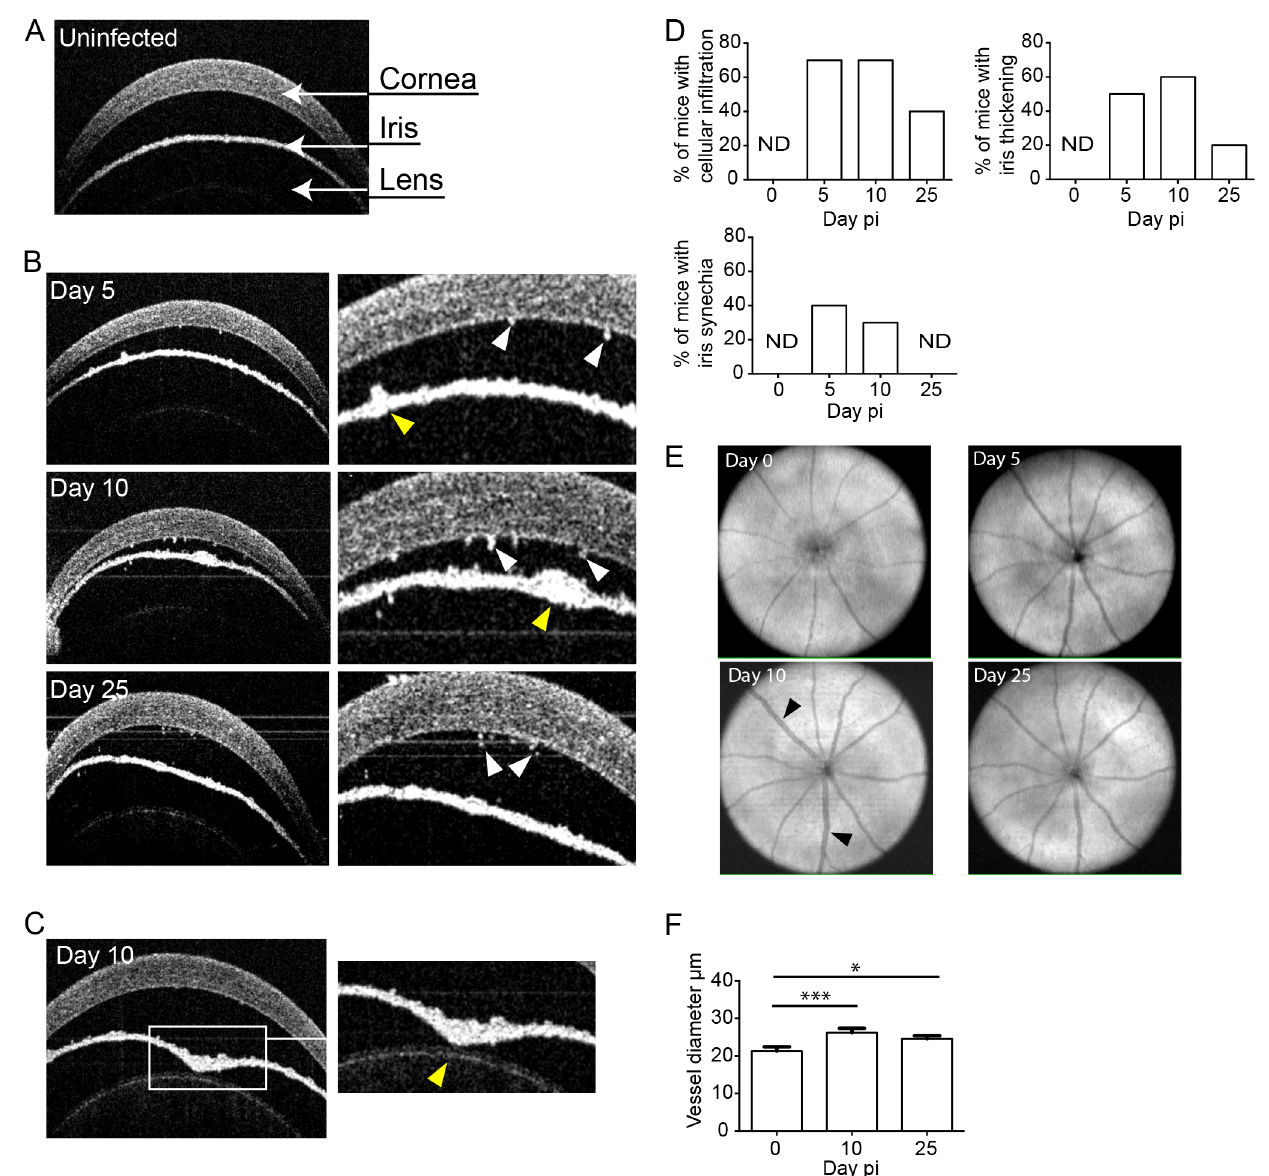
Fig 1. Pathological changes in the eye after systemic MCMV infection. (A) SD-OCT image of the anterior segment of the eye from an uninfected mouse. (B) Cross-sections of the anterior chamber from mice infected with MCMV at the indicated times pi. Cellular deposits (white arrows), vessel dilation and iris thickening (yellow arrows). (C) A representative image demonstrating iris bombe´, and the formation of synechia (yellow arrow). (D) The frequency of mice displaying the indicated pathological features following MCMV infection was quantified where n = 10 mice for each time point from at least 3 independent experiments. ND = not detected. (E) SD-OCT fundus images of the retina at the indicated times pi. Black arrows indicate retinal vessel enlargement (dilation and calibre variation). (F) Vessel diameter was measured at the indicated times pi with mean ± standard error of the mean (SEM) plotted, where n (cid:21) 8 eyes ( (cid:3) P = 0.035; (cid:3)(cid:3)(cid:3) P = 0.0006).